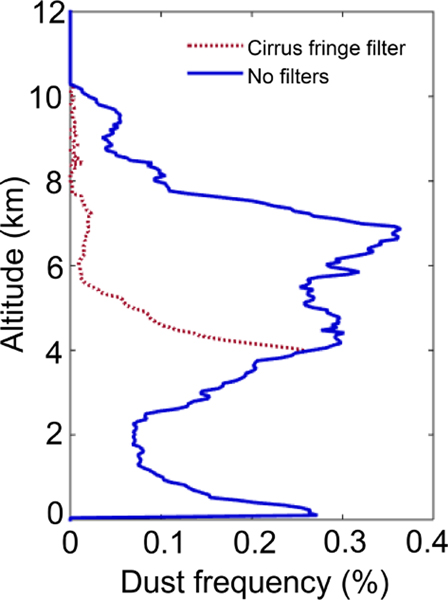
Dust detection frequency (100×Ndust/Nall aerosol) with and without the cirrus fringe filter for September–November 2010, at night over the south Pacific Ocean [30, 55° S; 80, 180° W].